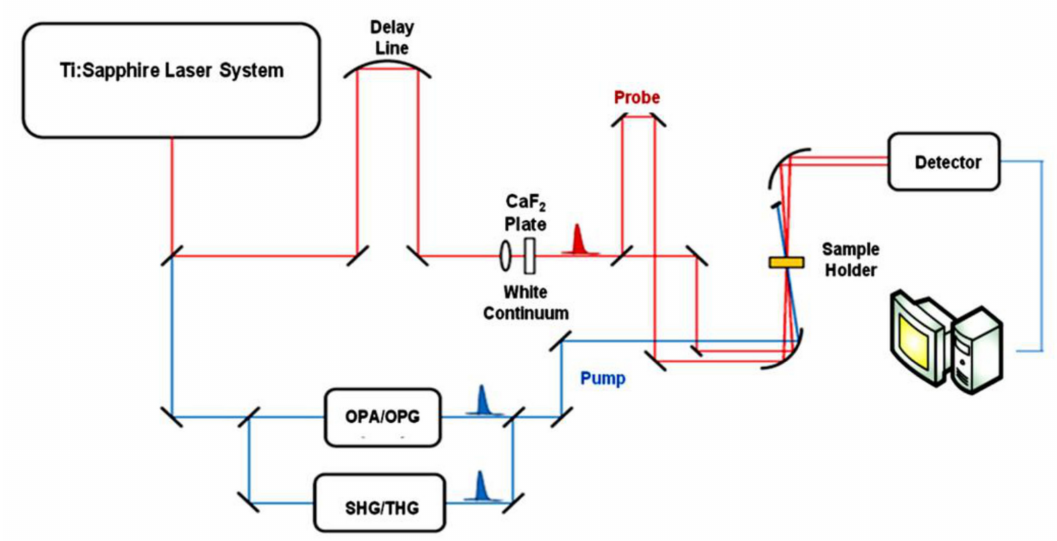
Figure 2. Scheme of a typical Transient Absorption Spectroscopy (TAS)